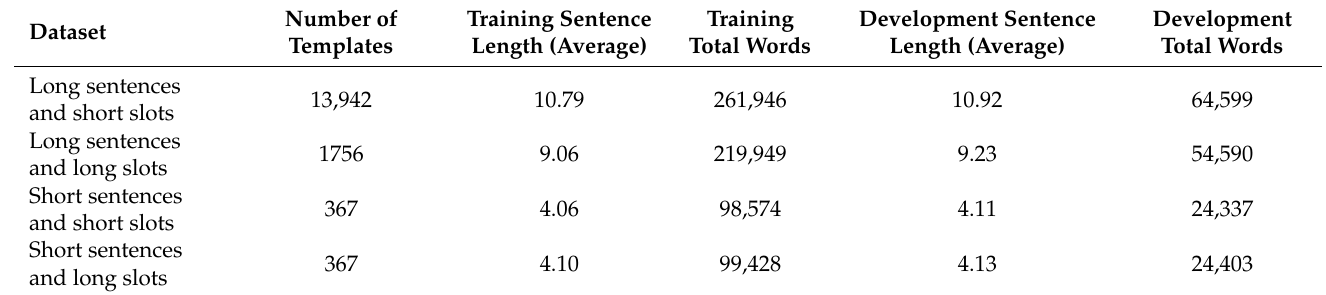
Table 1. Datasets